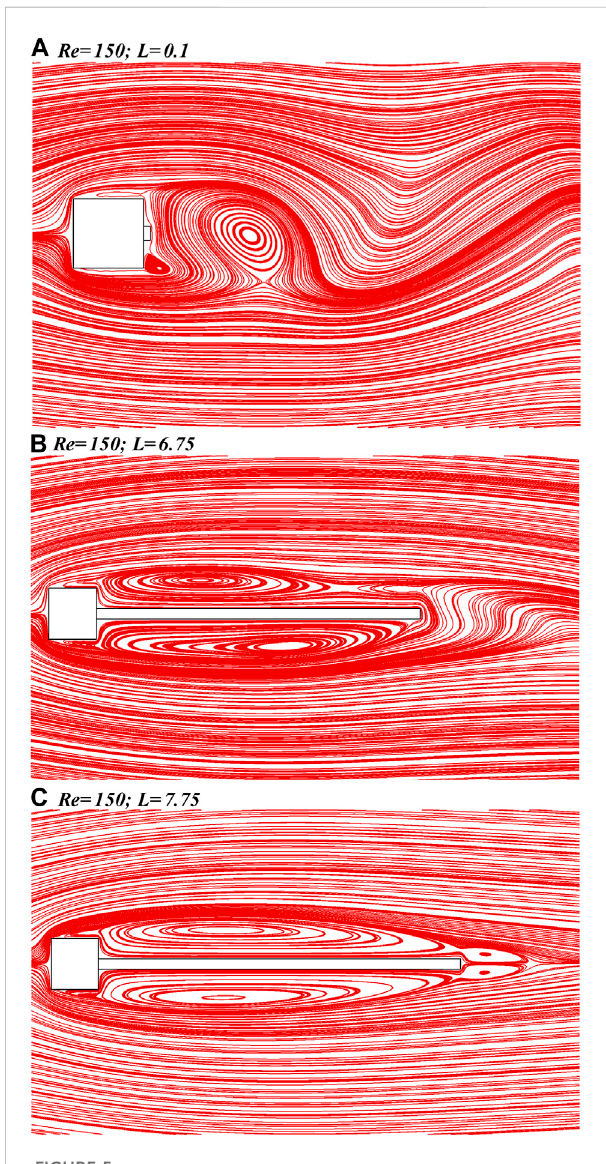
FIGURE 5 Streamlines graphs corresponding to different fl ow modes: (A) Unsteady, (B) Tranisent, and (C) Steady fl ow